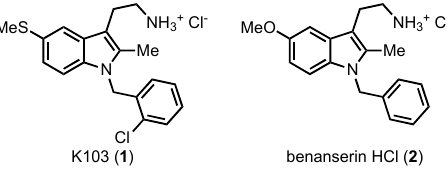
Figure 2. Structure of the pan-SHIP1/2 inhibitor K103 and Benanserin HCl.